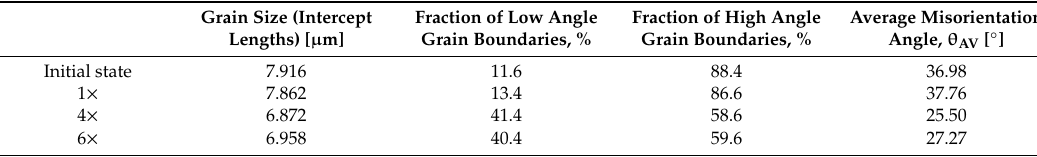
Figure 5. Electron backscattered di ff raction (EBSD) inverse pole figure (IPF) maps of 5754 aluminum alloy ( a ) initial state, ( b ) one DRECE pass, ( c ) four DRECE passes, ( d ) six DRECE passes. Table 3. Summarized results of the EBSD